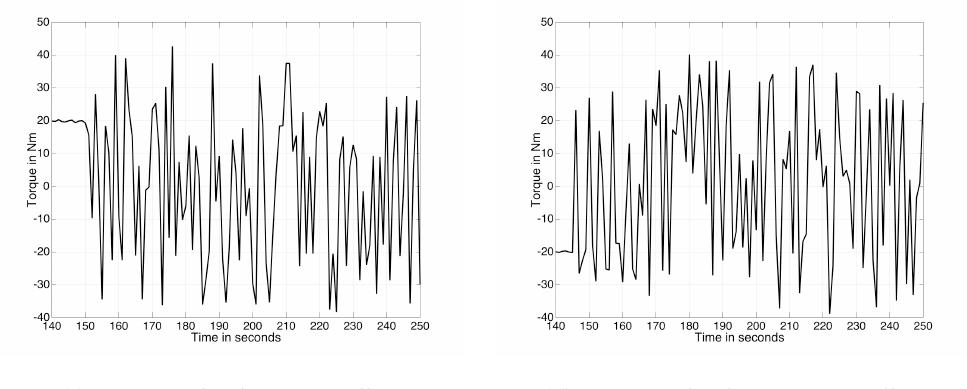
Figure 9. Ramp response of the